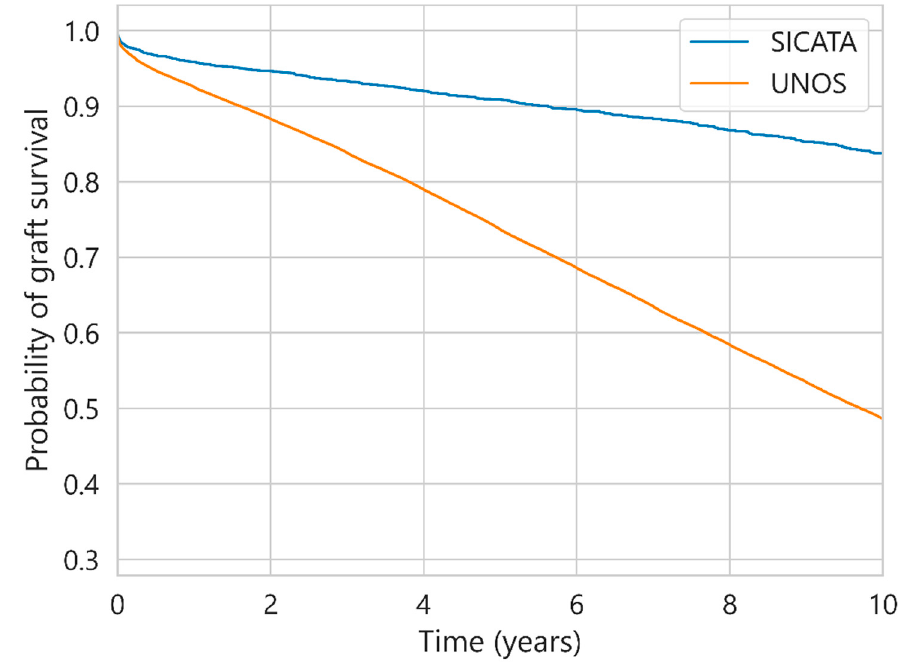
Figure 1. Probability of graft survival for UNOS and SICATA.